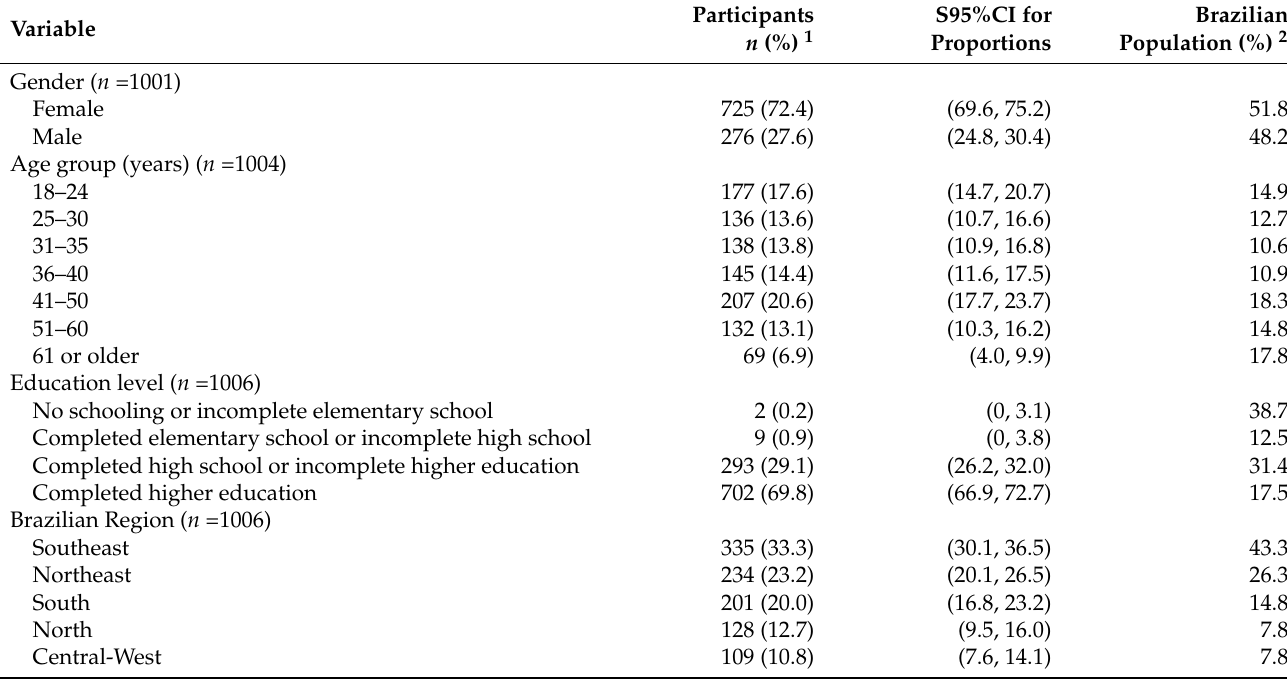
Table 1. Characteristics of the study participants and comparisons with the profile of the Brazilian